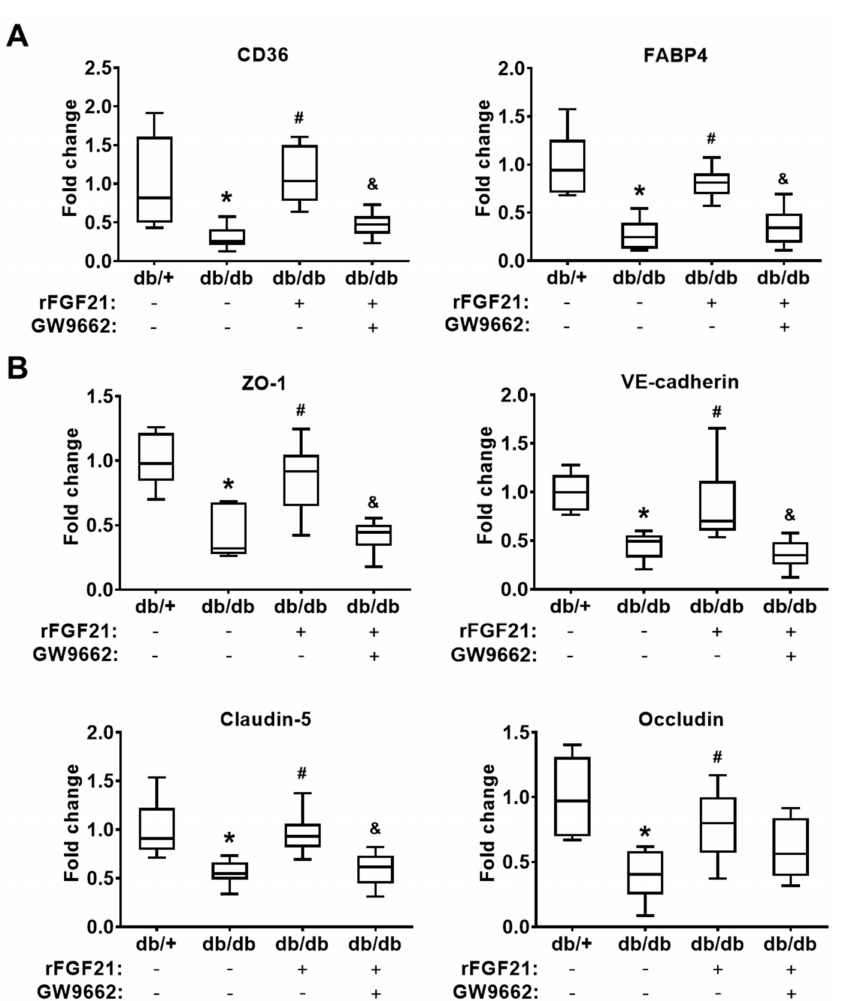
Figure 3. rFGF21 inhibits reduction of junction protein mRNA expression via cerebrovascular PPAR γ activation after dMCAO in db / db mice. At 24 h poststroke, mRNA levels of CD36, FABP4, ZO-1, VE-cadherin, claudin-5, and occludin were measured by RT-PCR. ( A ) Relative fold changes of PPAR γ -targeted genes CD36 and FABP4 . ( B ) Relative fold changes of junction protein genes ZO-1 , VE-cadherin, claudin-5, and occludin. Data are illustrated as box-plots with the median, lower and upper quartiles, minimal and maximal value ( n = 6 per group). * p < 0.05 for db / db stroke vs. db /+ stroke; # p < 0.05 for db / db stroke + rFGF21 vs. db / db stroke; & p < 0.05 for db / db stroke + rFGF21 + GW9662 vs. db / db stroke +